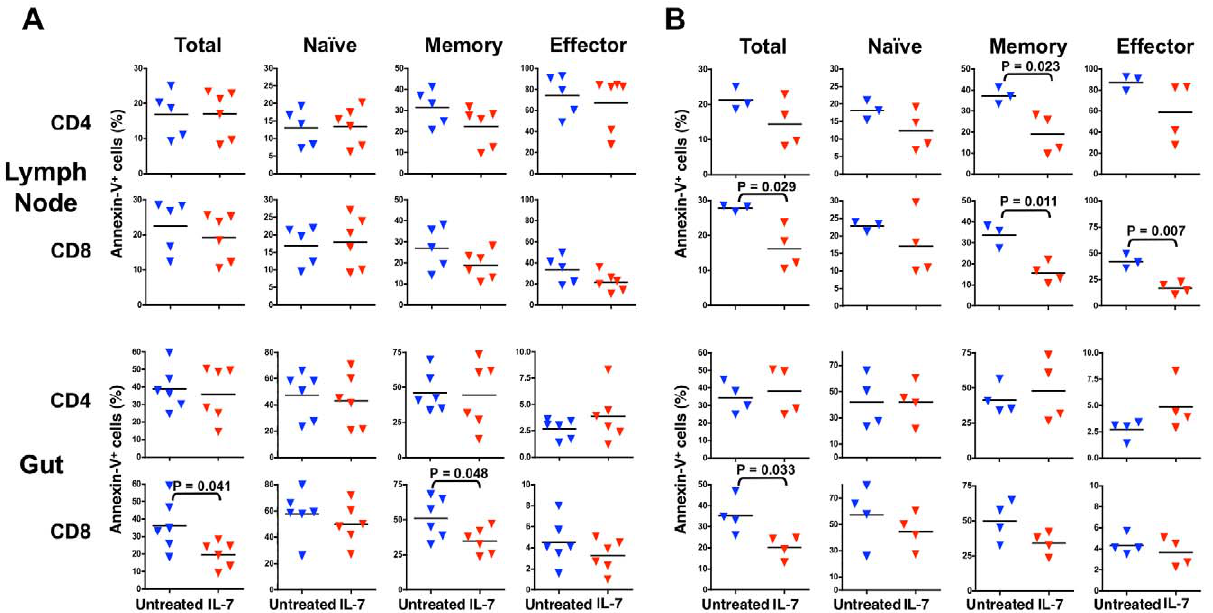
Figure 5. Frequency of CD4 + and CD8 + T-cell subsets and analysis of spontaneous apoptosis in terminal ileum and lymph node biopsies from untreated and IL-7-treated macaques. Lymph node (upper panels) and gut (lower panels) biopsies were obtained from all animals on days 25–27 and on days 14–16 post-infection, respectively. (A) Mean levels of spontaneous apoptosis, as measured by Annexin-V binding, in total, naı¨ve, memory and effector CD4 + and CD8 + T cells isolated from axillary lymph node and terminal ileum biopsies from untreated (blue) and IL-7-treated (red) animals. The differences between untreated and IL-7-treated animals were analyzed by unpaired t-test (similar results were obtained by Wilcoxon rank sum test). (B) Mean levels of spontaneous apoptosis, as measured by Annexin-V binding, on total, naı¨ve, memory and effector CD4 + and CD8 + T cells freshly isolated from axillary lymph node and terminal ileum biopsies from untreated (blue) and IL-7-treated (red) animals, after the exclusion of 4 rapid progressor (RP) animals. The differences between untreated and IL-7-treated animals were analyzed by unpaired t-test.